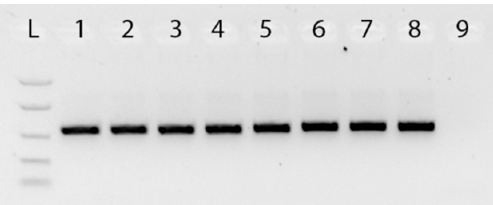
Figure 1. Agarose gel electrophoresis of PCRs using rbcL generic primers. Gel lanes: L. Easy Ladder I